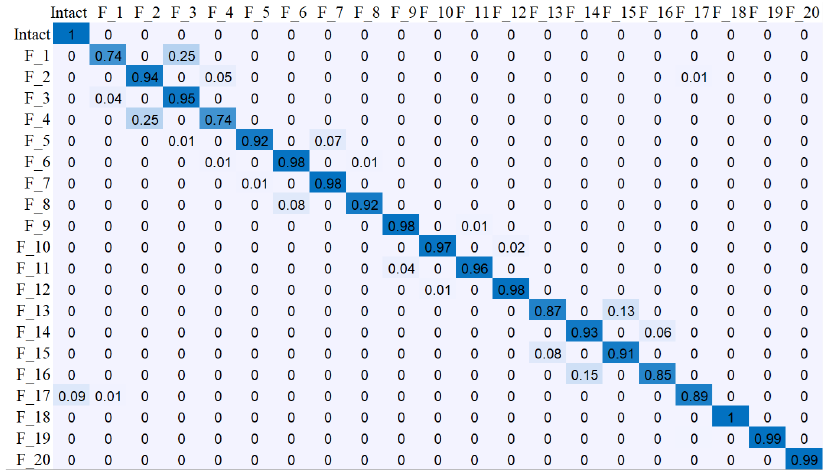
Figure 13. Failure detected location when there are 5 sensors at points 3, 4, 5, 6, and 7 (Accuracy: 92.9%).